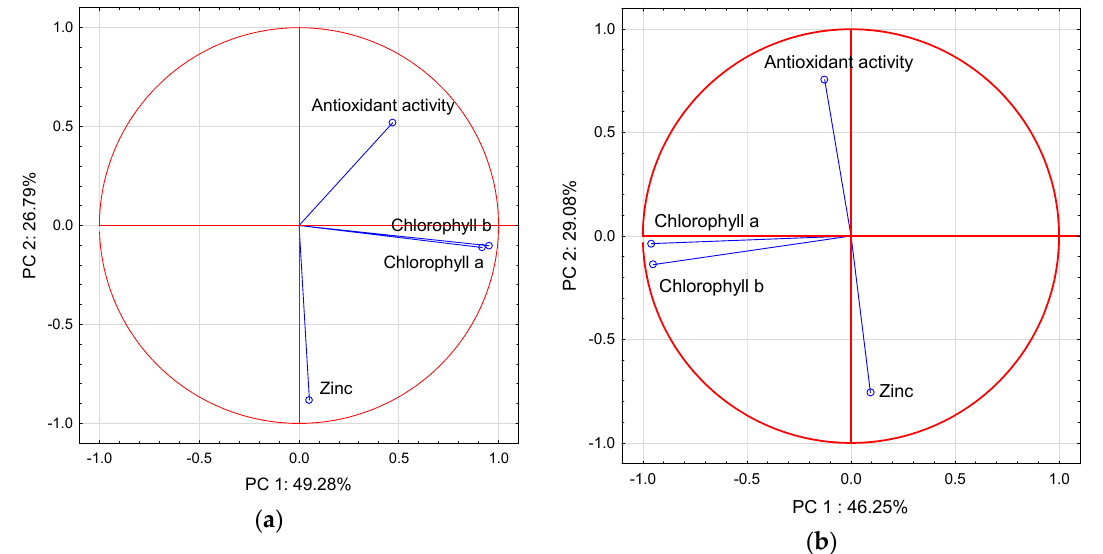
Figure 7. Biplot presenting the correlation between the tested parameters of onion bulbs of investigated cultivars, on a basis of data collected from 3 years of investigations. Stuttgarter Riesen ( a ) and Rote Laaer ( b ).